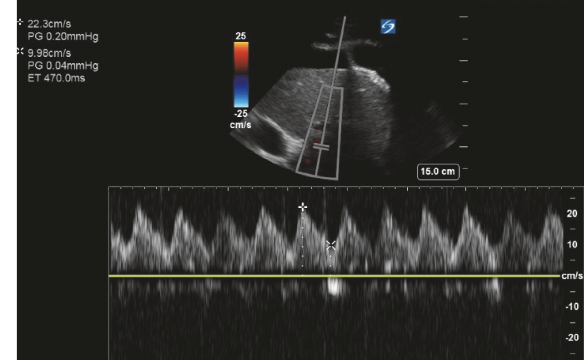
Figure 2: Portal vein Doppler exam on day 3. Maximum and minimum velocities are 22.3 and 9.98 cm/s, respectively. Pulse is 102 bpm. Portal vein pulsatility fraction is 59 %. Ascites is once again